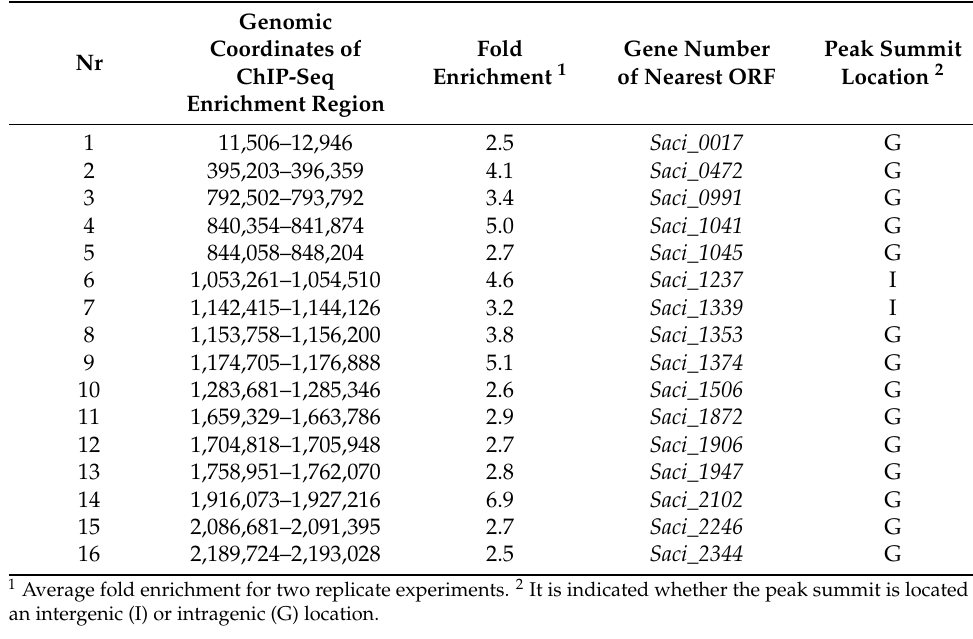
Table 1. Summary of ChIP-seq results.